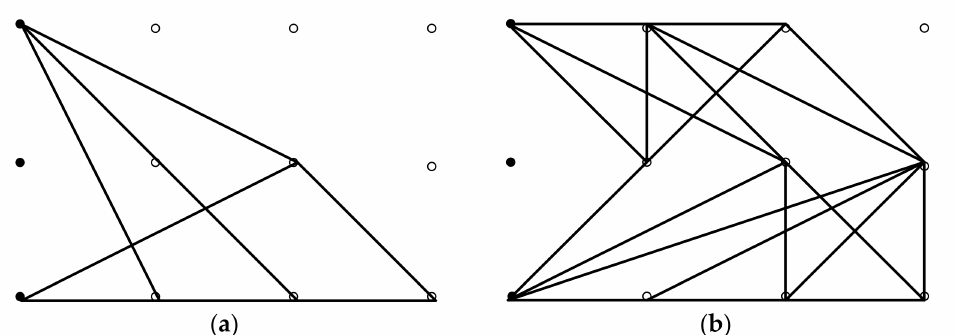
Figure 13. ( a ) Optimization results in this paper; ( b ) Optimization results in this paper without the LCS